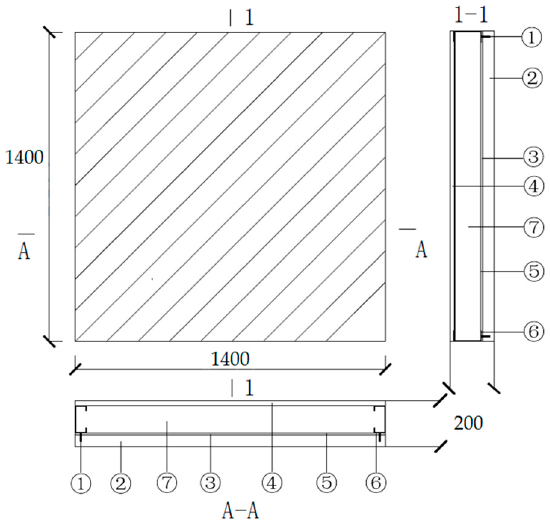
Figure 1. Configuration of LAEWP (unit: mm). ① steel stud, ② high strength concrete, ③ U-shape light-gauge steel, ④ fiber concrete board, ⑤ air layer, ⑥ C-shape light-gauge steel, and ⑦ EPS insulation layer.